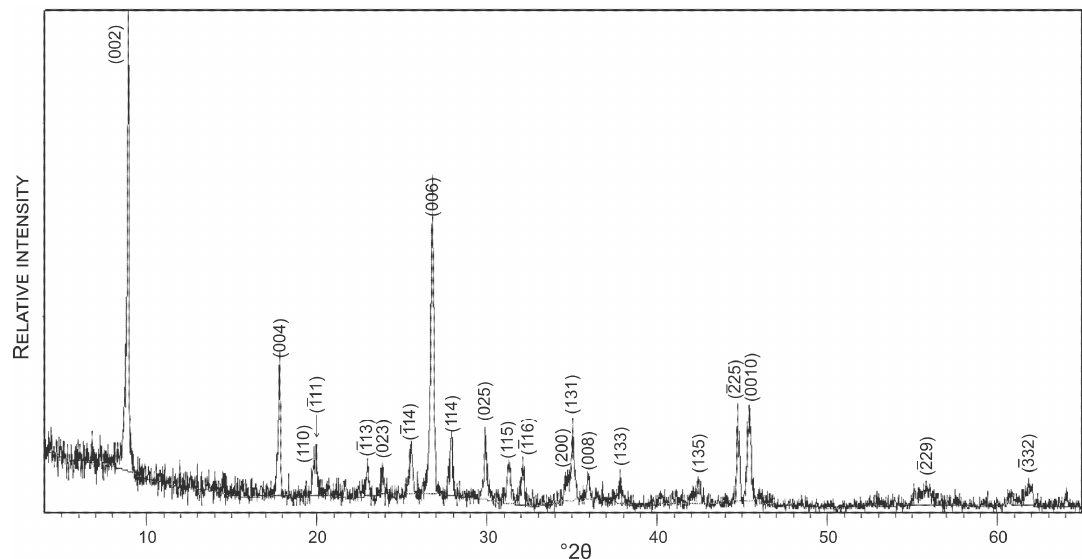
Figure 7. XRD pattern of muscovite dated by the of 40 Ar/ 39 Ar technique.